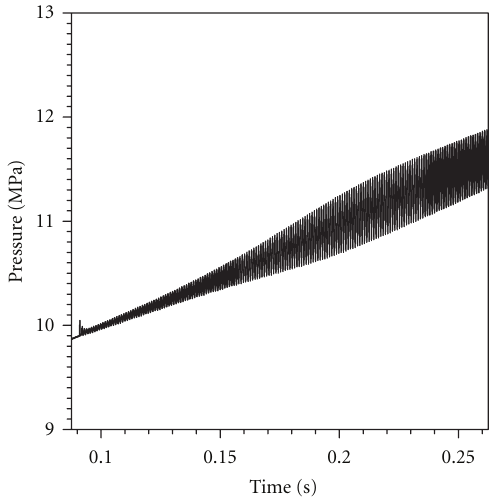
Figure 3: Predicted head-end pressure-time profile, reference motor ( K b = 20000 s − 1 , Δ H s = 150000 J/kg, Δ p 0%), acceleration nullified, no particles.